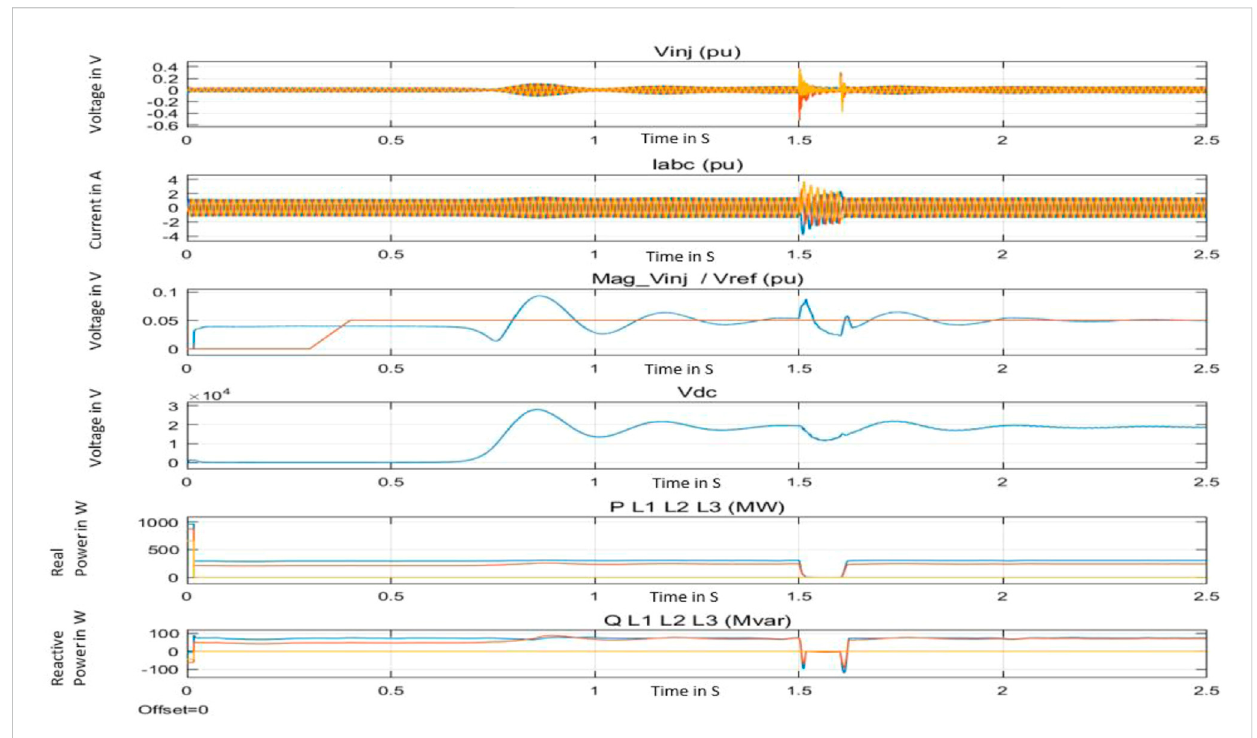
FIGURE 7 PI controller results after connecting the